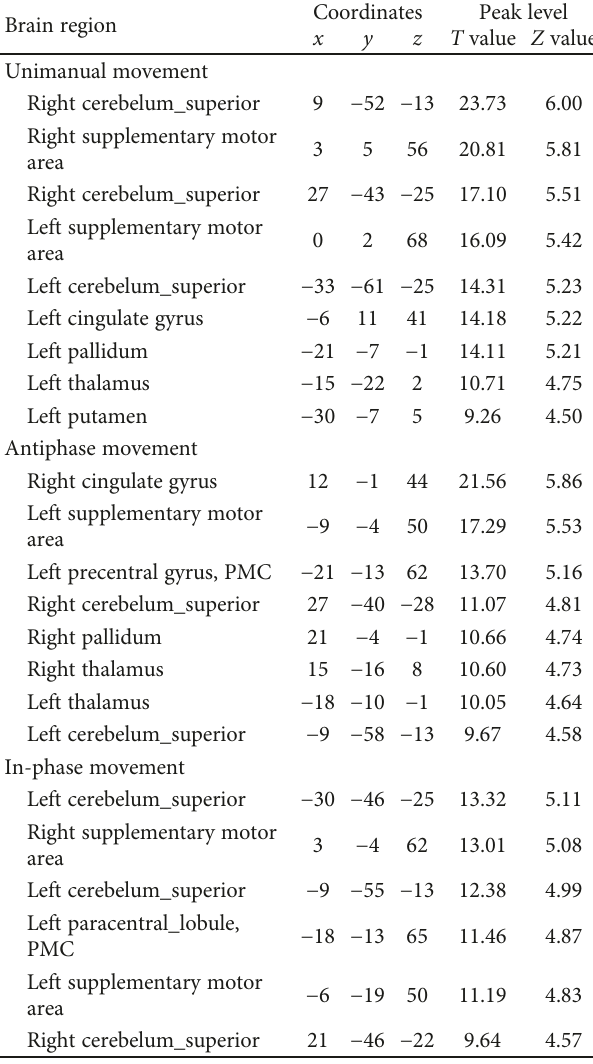
Table 1: Brain regions activated during performing unimanual movements (right elbow) and bimanual movements (antiphase and in-phase) in the normal subject group. Results were thresholded at P < 0 0001 , noncorrected, and cluster size >